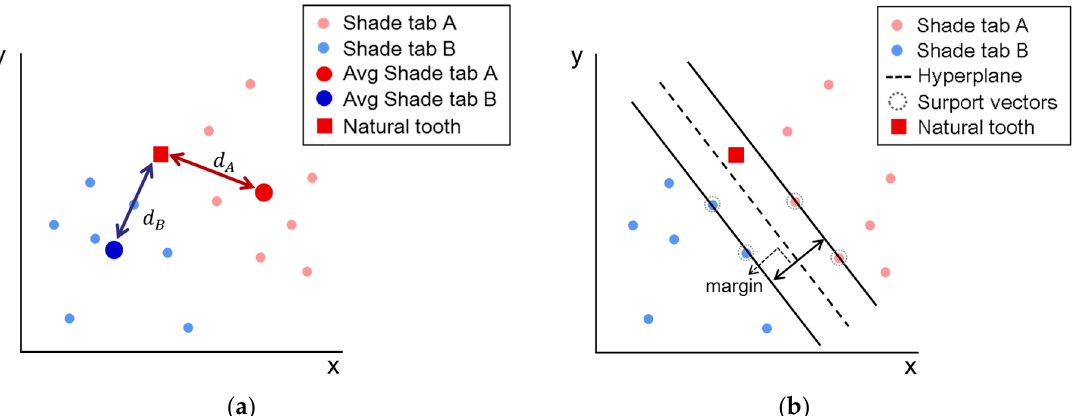
Figure 4. Example for selecting a shade tab by ( a ) the Euclidean distance and ( b ) the support vector machine algorithm. ( x -axis: Commission Internationale de l’Eclairage (CIE) a* value, y -axis: CIE b* value, small red and blue circles: mean colors of shade tabs A and B; large red and blue circles: averaged color of the mean color group; red square: mean color of the natural tooth).